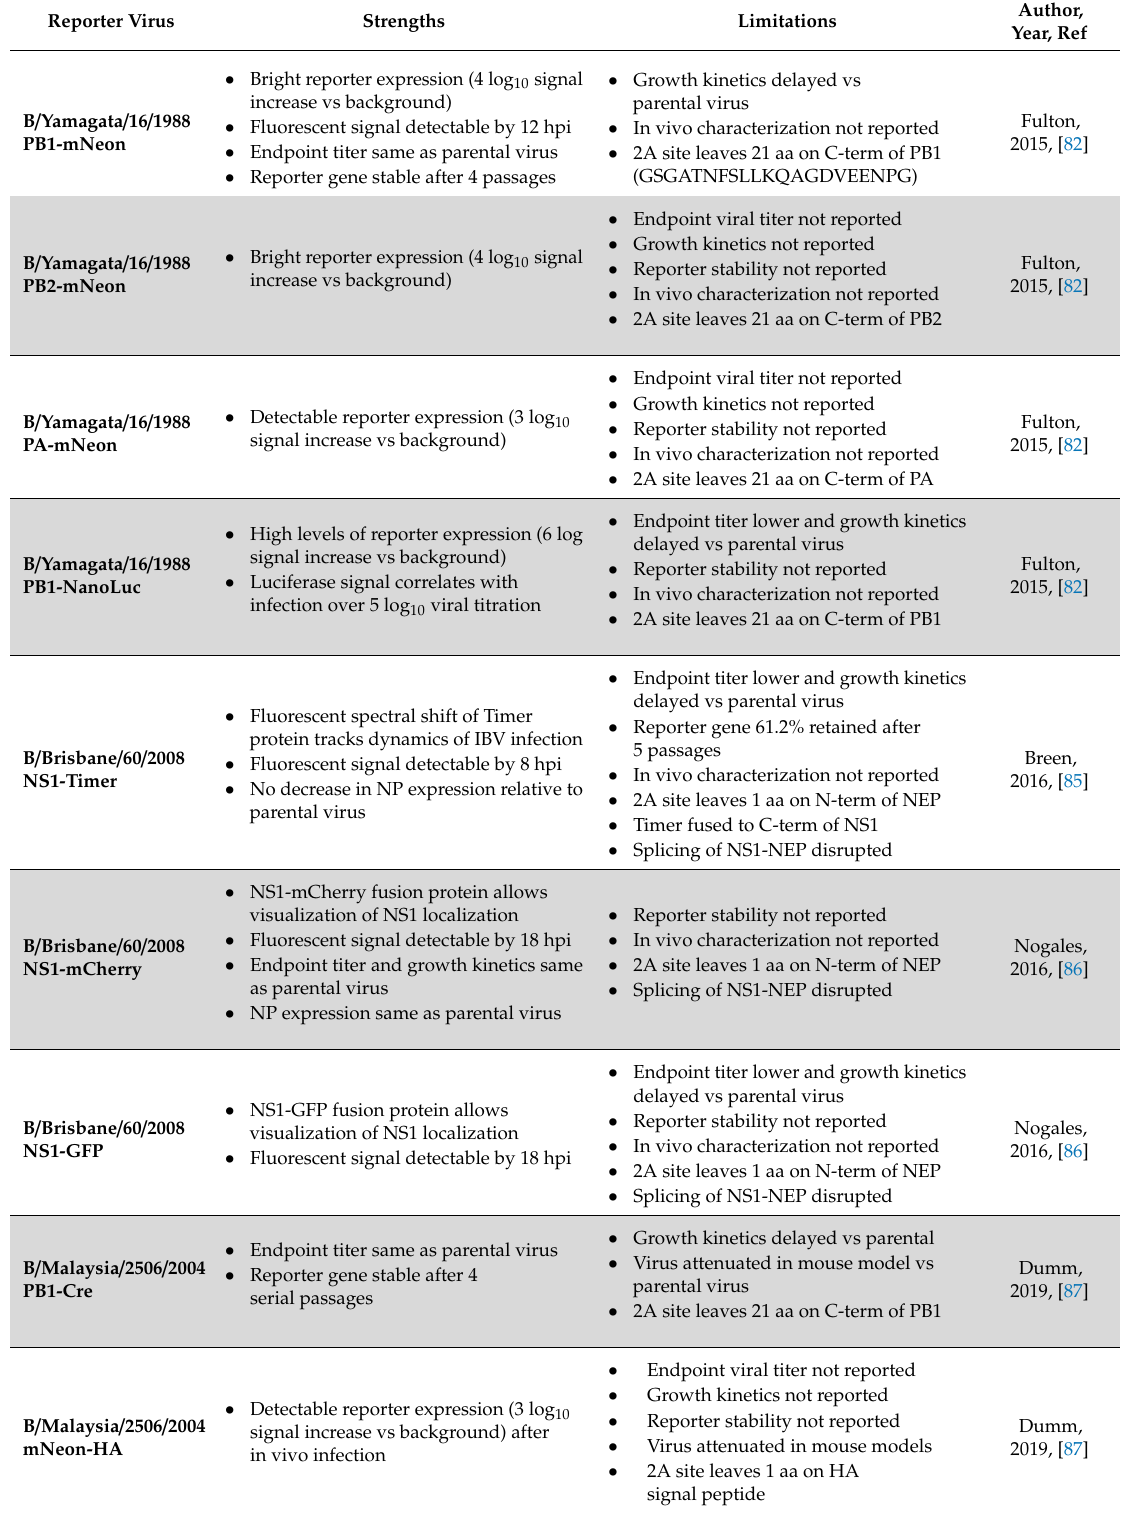
Table 1. Overview of published replication-competent reporter influenza B viruses and their strengths, limitations, and corresponding